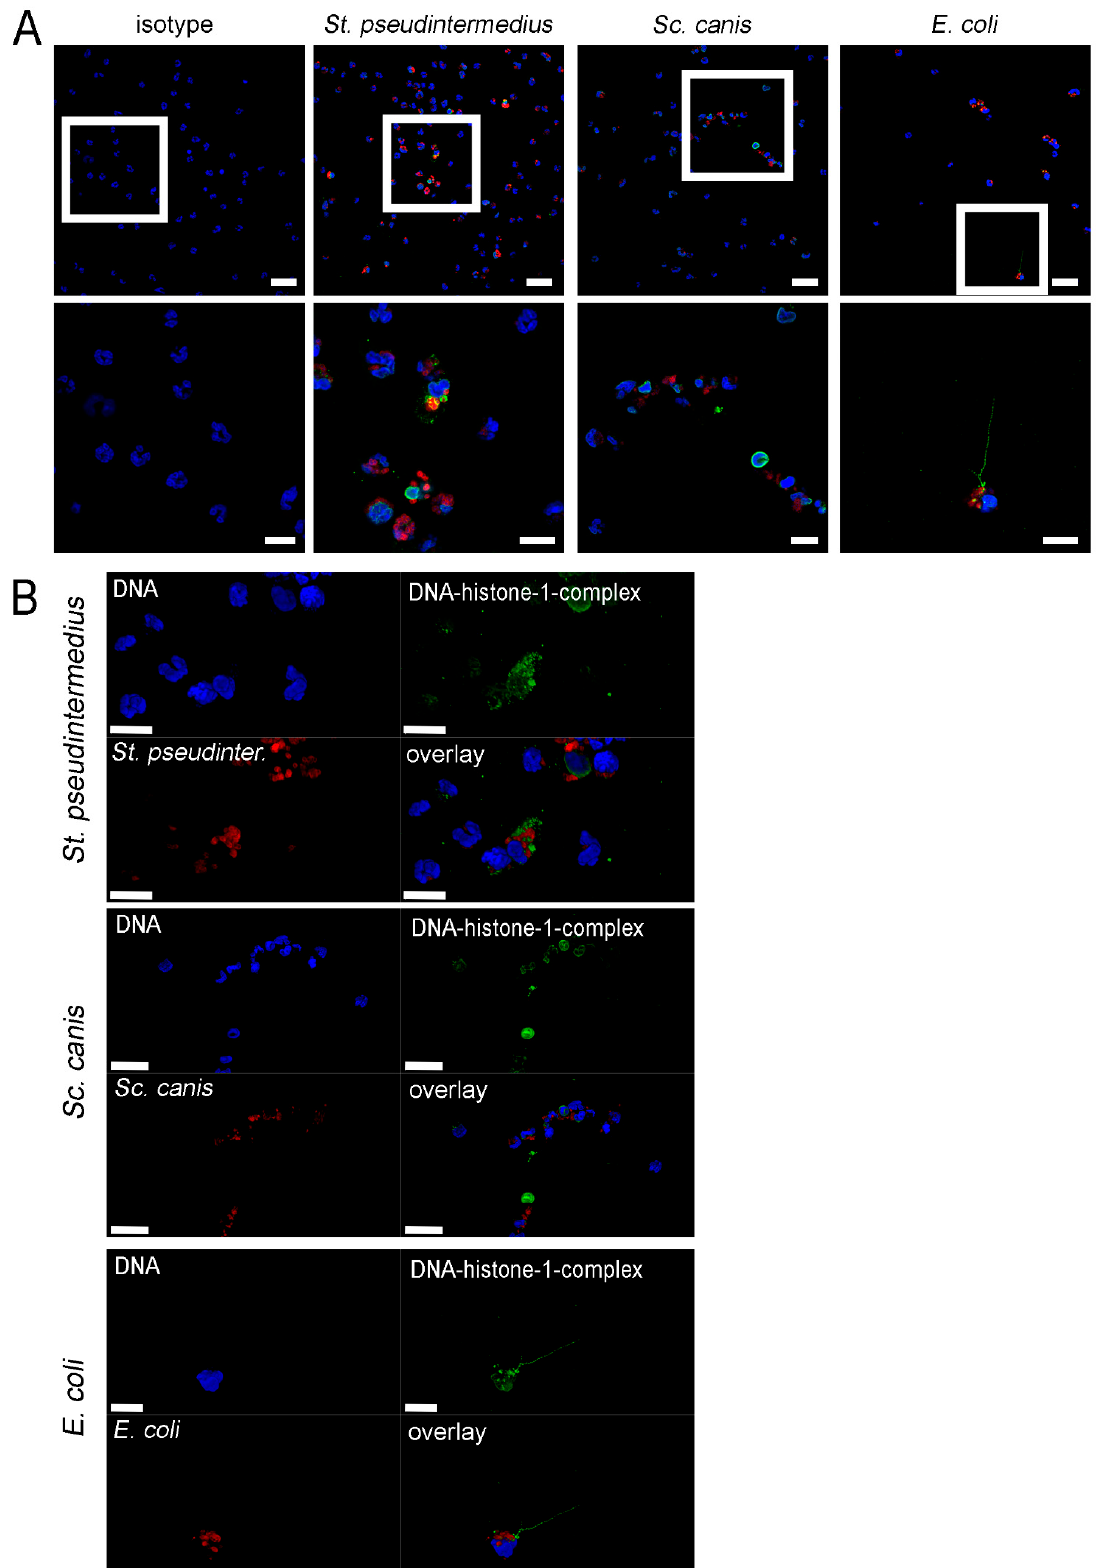
Figure 6. Phagocytosis and NET formation are detected in canine neutrophils after 3 h incubation with methylprednisolone. ( A ) By immunofluorescence microscopy, neutrophils were analyzed after three hours of incubation with 625 µ g/mL methyl- prednisolone and bacteria for NET release and phagocytosed bacteria (Green = DNA/histone-1 complexes, red =